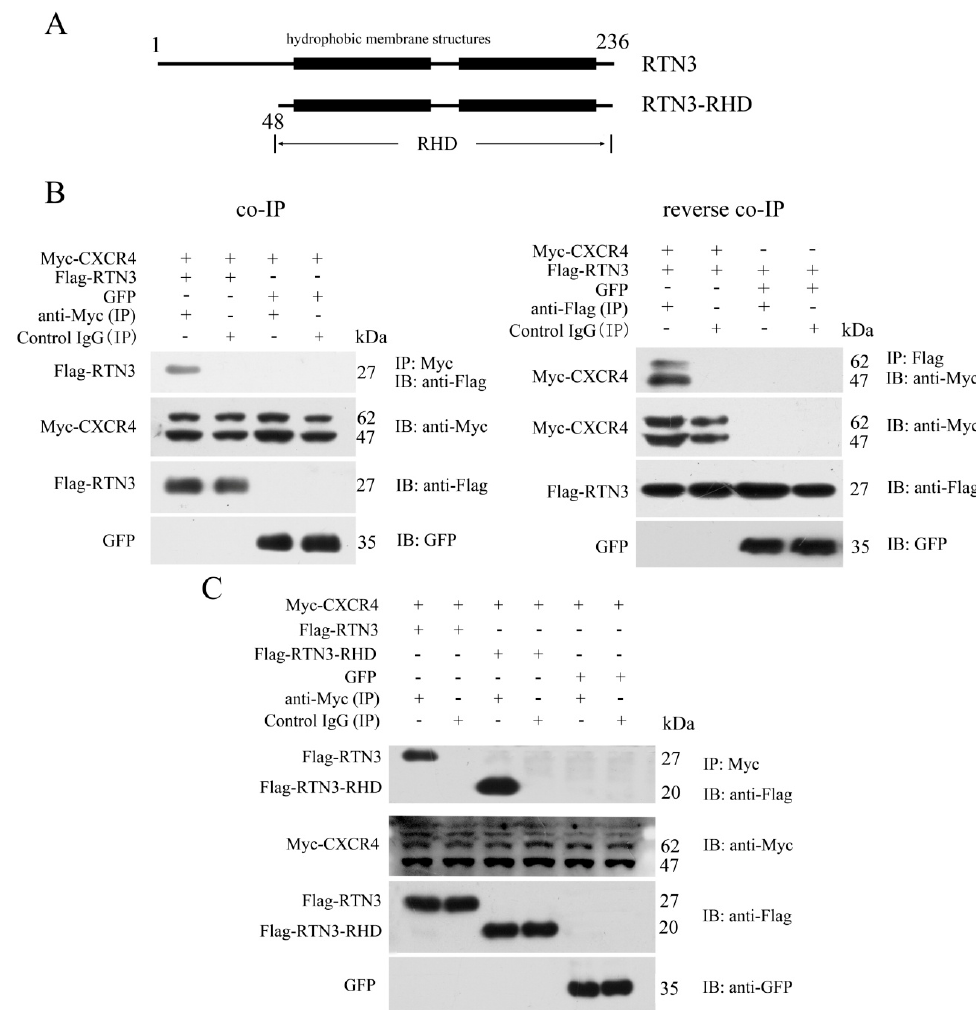
Figure 1. Specific interaction of CXCR4 with the RHD of RTN3. ( A ) Schematic representation of RTN3 and RTN3-RHD. Amino acid residues 48 to 236 comprise the RHD of RTN3; ( B ) The interaction between Myc-CXCR4 and Flag-RTN3. Myc-hCXCR4, Flag-hRTN3, and GFP were overexpressed in HEK293 cells. Cell lysates were immunoprecipitated with anti-Myc or anti-Flag or control IgG